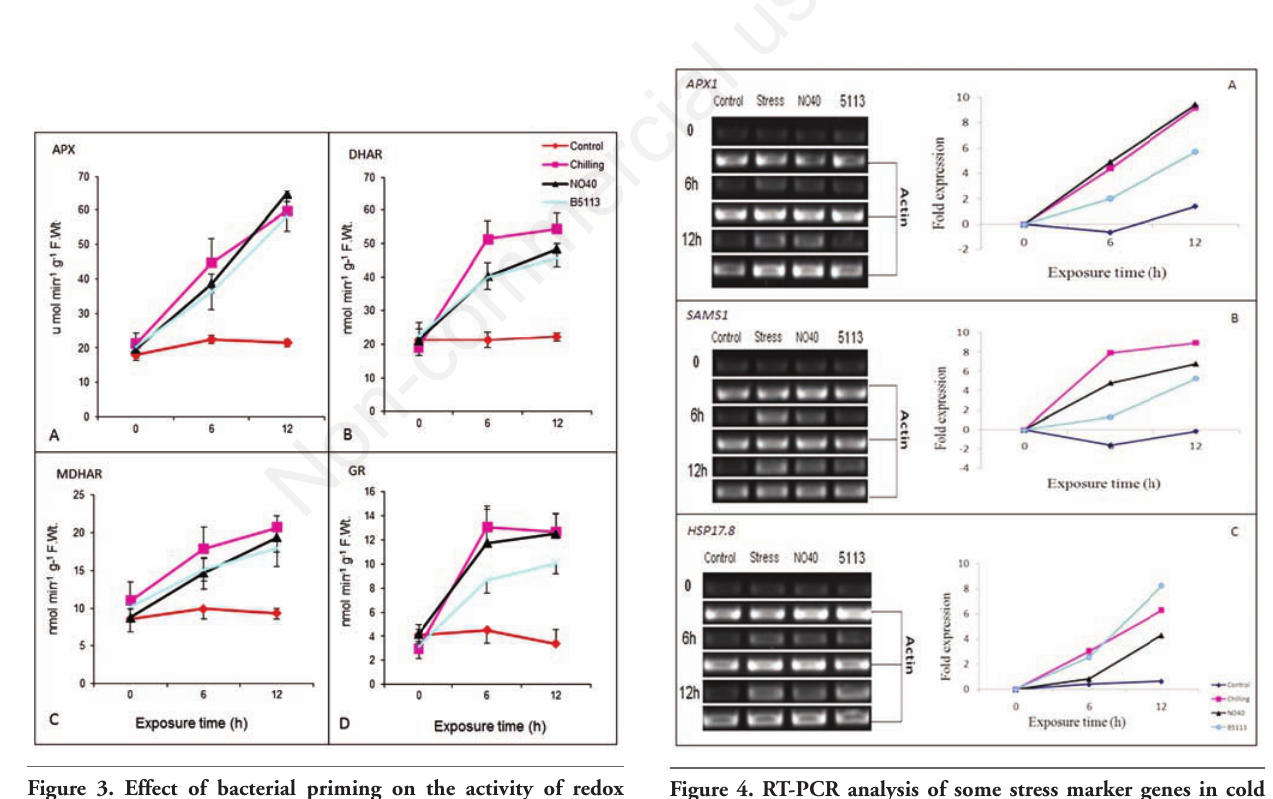
Figure 4. RT-PCR analysis of some stress marker genes in cold stressed wheat leaves. Wheat plants (cv. Sids1) pretreated with B. amyloliquefaciens 5113 ( ) or A. brasilense ( ) NO40 were ▲ exposed to −5°C for 0, 6 and 12 h. Semi-quantitative RT-PCR ● analysis was used to study steady state levels of APX1 (A), SAMS1 (B) and HSP17 .8 (C) expression. The cytoskeleton gene ACTIN was used to normalize expression levels. The expression is shown as the relative fold expression to the control ( ) at zero ♦ time. Cold treated plants without priming served as stress posi- tive control ( ■